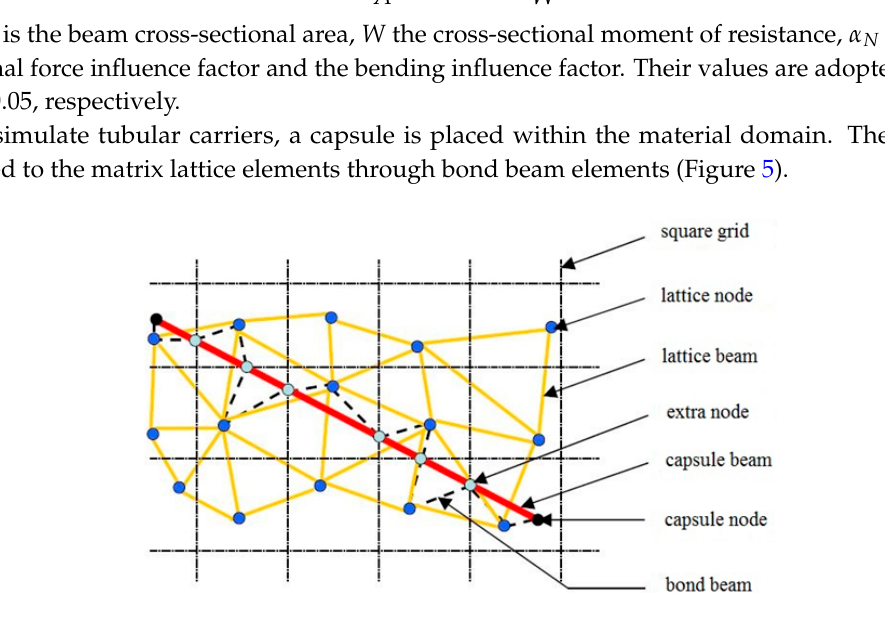
Figure 5. Schematic 2D representation of generation of capsule-lattice and their contact.